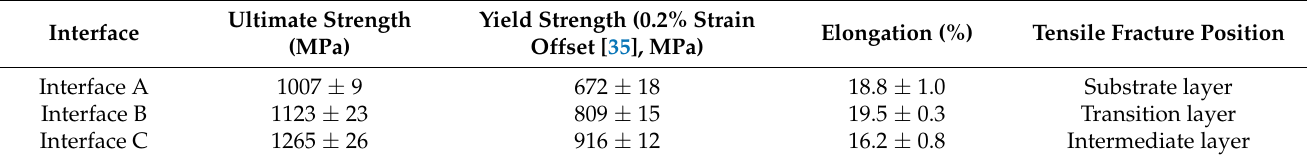
Table 5. Tensile properties of gradient interfaces.